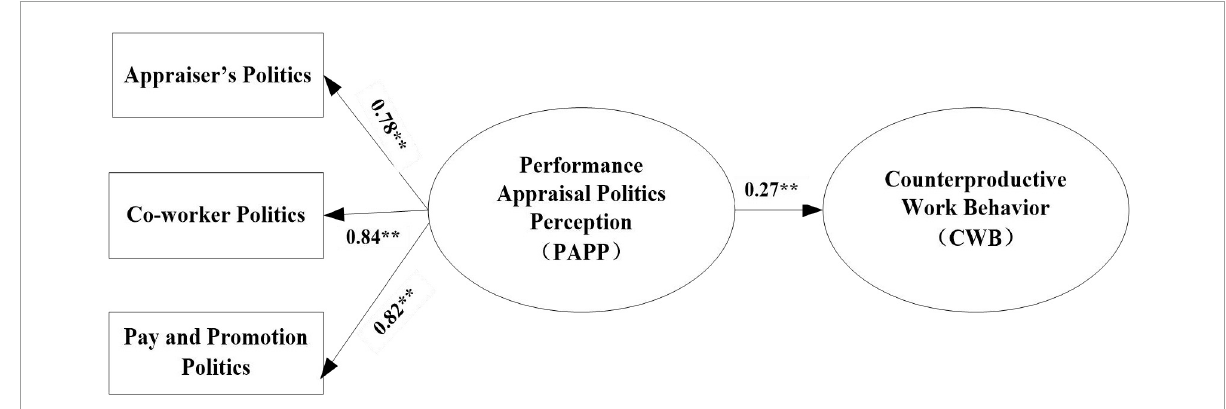
FIGURE2 The model of direct relationship between PAPP and CWB. N = 460, ** p <